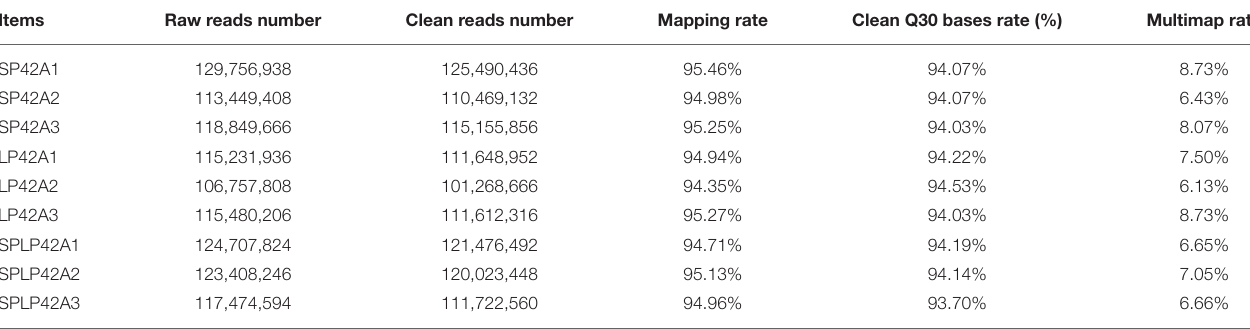
TABLE 1 | Summary of the mapping data from the adrenal gland tissues.